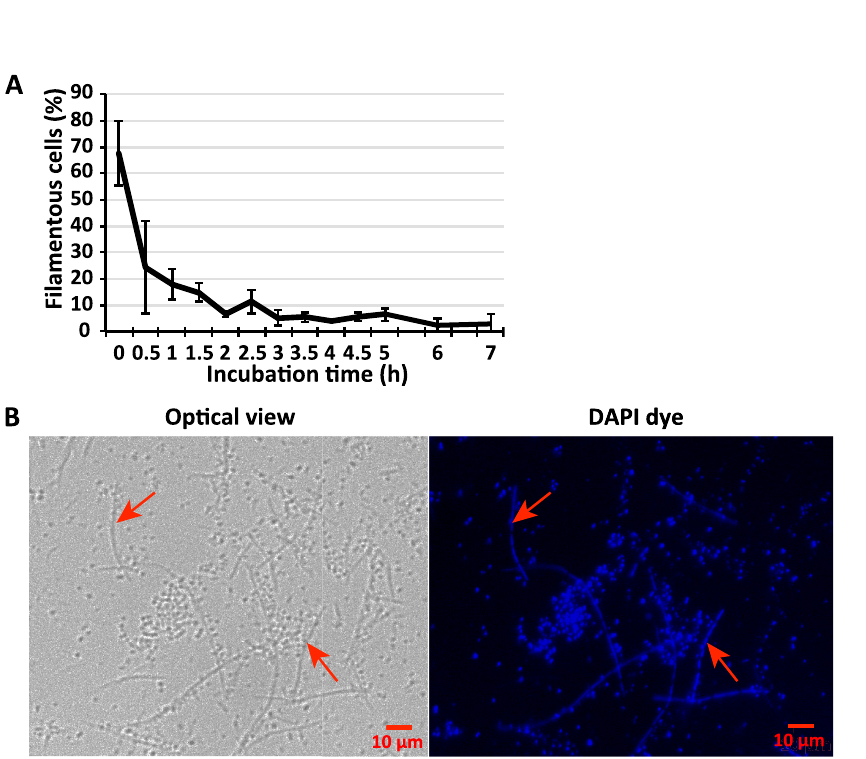
Fig 11. (A) Percentage of filamentous cells ( > 10 μ m) of D . dadantii upon exposure to fresh potato tuber tissues for different period of time. The filamentous cells were collected from the surface center (P2) of an infected potato tuber slide after 48 hpi, and transferred onto a freshly dissected potato tuber. (B) DAPI staining of the nucleoids of D . dadantii collected from the surface center (P2) of the infected potato tuber in the absence of freestanding water, at 48 hpi. The representative filamentous cells, which contained multiple, segmented nucleoids, were indicated by arrows. The experiments were repeated three times with similar